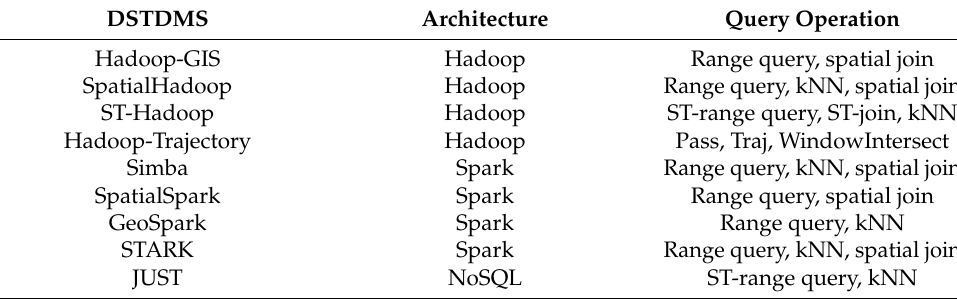
Table 1. The most representative DSDMSs with functional comparisons.